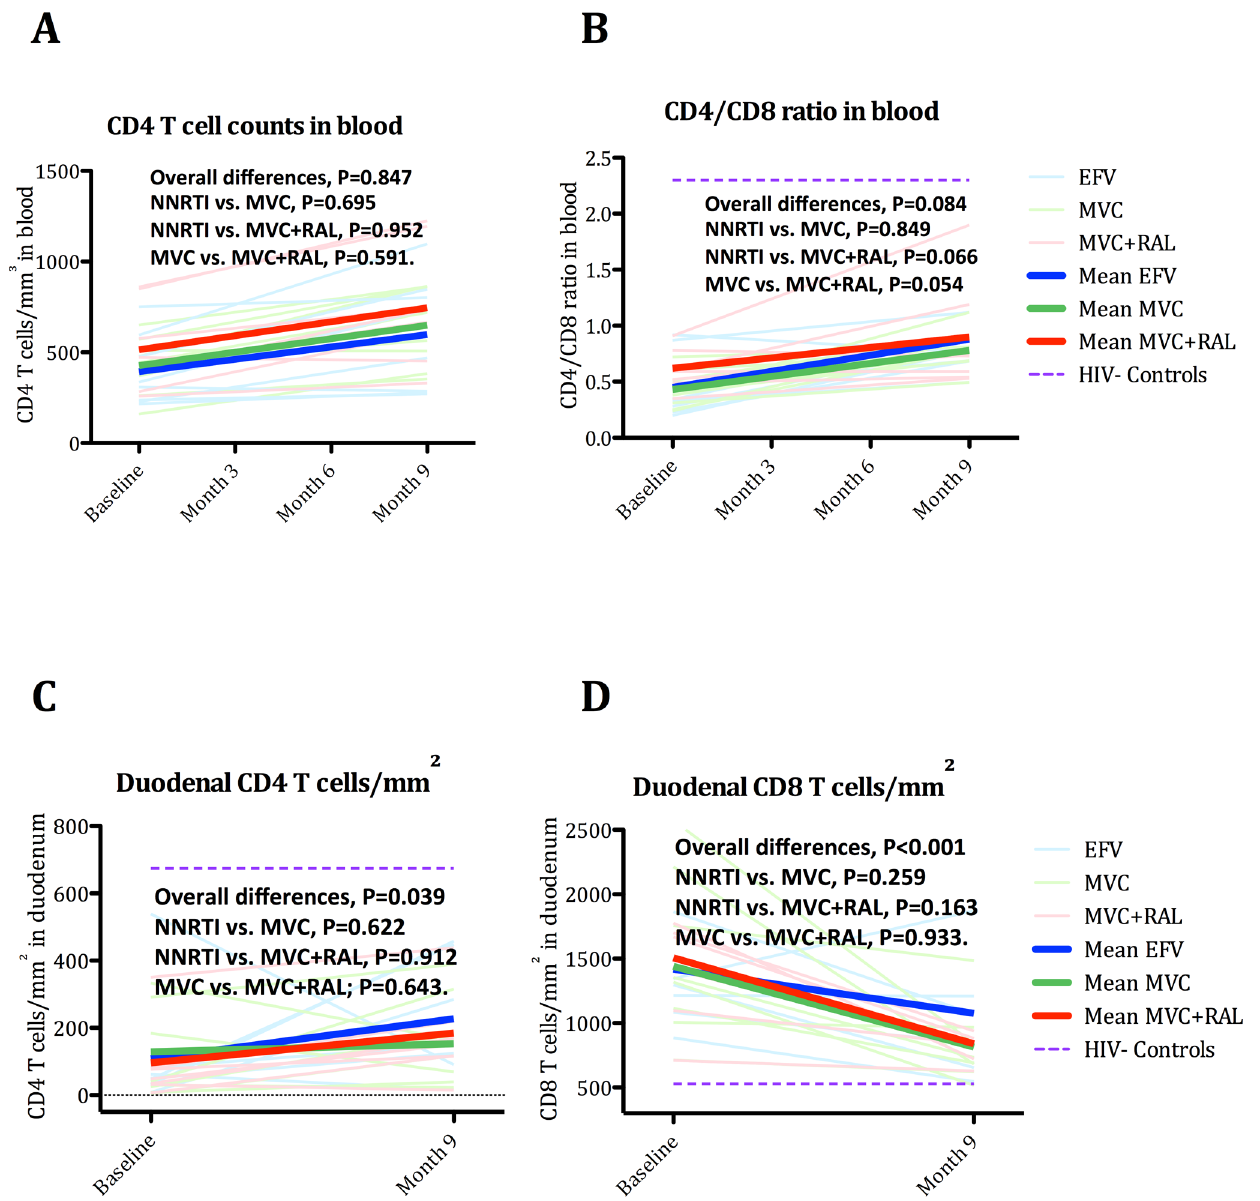
Fig 2. Changes in peripheral and duodenal CD4 + and CD8 + T-cells. Panel A. Changes in peripheral CD4 + T-cell counts. Panel B. Changes in peripheral CD4/CD8 ratio. Panel C. Changes in duodenal CD4 + T-cell density. Panel D. Changes in duodenal CD8 + T-cell density. The purple dash line represents cross-sectional mean values in controls. The equality of all mean changes among the three groups was tested using a Wald test for the interaction term and is referred as “ Overall differences ” . A statistically significant interaction term (group * month) identified significantly different slopes between treatment